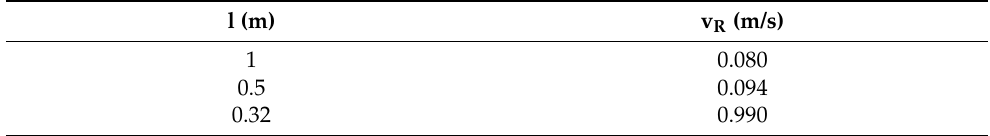
Table 6. RC—generated flow velocity in forward direction at 500 RPM.